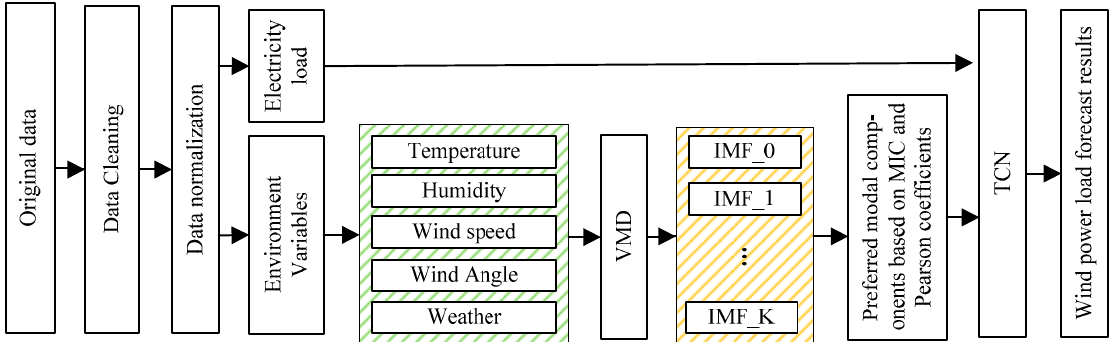
Figure 3. Flow chart of wind power short-term forecasting model based on